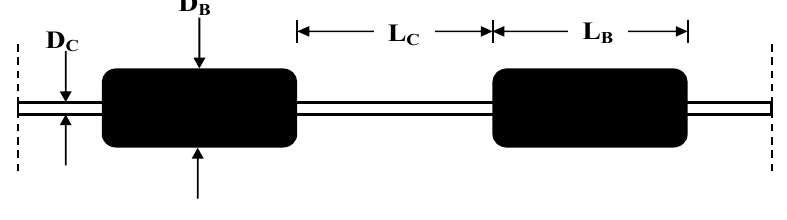
Figure 6. Definitions of LC, LB, DC, and DB.